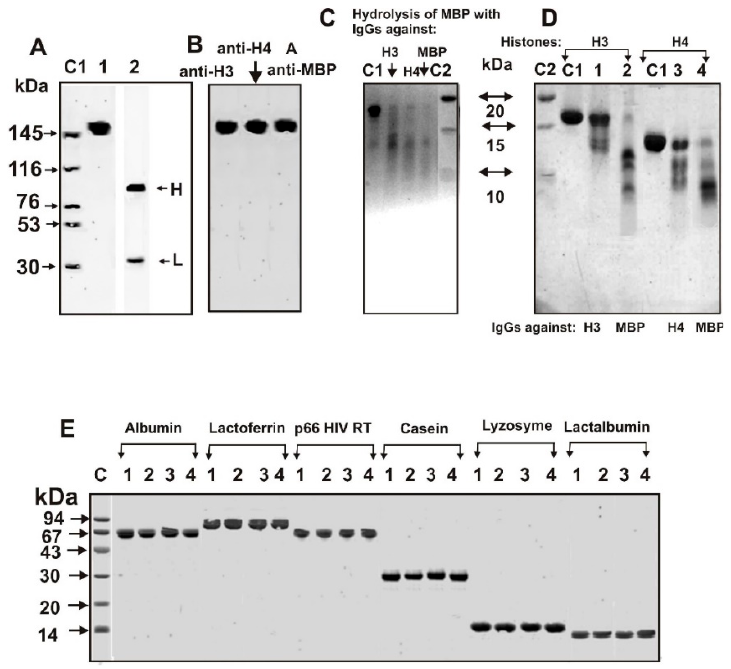
Figure 1. SDS-PAGE analysis of homogeneity of initial IgG mix (12 µg) in 4%–18% gradient gel before (lane 1) and after treatment with dithiothreitol (DTT) (lane 2) ( A ), as well as anti-H3, anti-H4, and anti-MBP Abs after initial IgG mix separation on columns with corresponding affinity sorbents ( B ), followed by silver staining. The arrows (lane C1) indicate the positions of molecular mass markers. SDS-PAGE analysis of MBP hydrolysis with anti-H3 (lane 1) and anti-H4 (lane 2) and anti-MBP IgGs (lane 3) ( C ). SDS-PAGE analysis of H3 hydrolysis with anti-H3 (lane 1) and anti-MBP IgGs (lane 2) as well as H4 hydrolysis with anti-H4 (lane 3) and anti-MBP IgGs (lane 4) ( D ). C1 lanes correspond to MBP ( C ), H3, and H4 ( D ) incubated in the absence of Abs. Lanes C2 correspond to standard proteins with known molecular masses. The hydrolysis of different control proteins in the absence of IgGs (lanes 1) or in the presence of IgGs against H3 (lanes 2), H4 (lanes 3), and MBP (lanes 4) ( E ). Native albumin, human milk lactoferrin, p66 HIV-1 reverse transcriptase (HIV-1 RT), human milk casein, human lysozyme, and human lactalbumin are shown on Panel E. Lane C correspond to proteins with known molecular